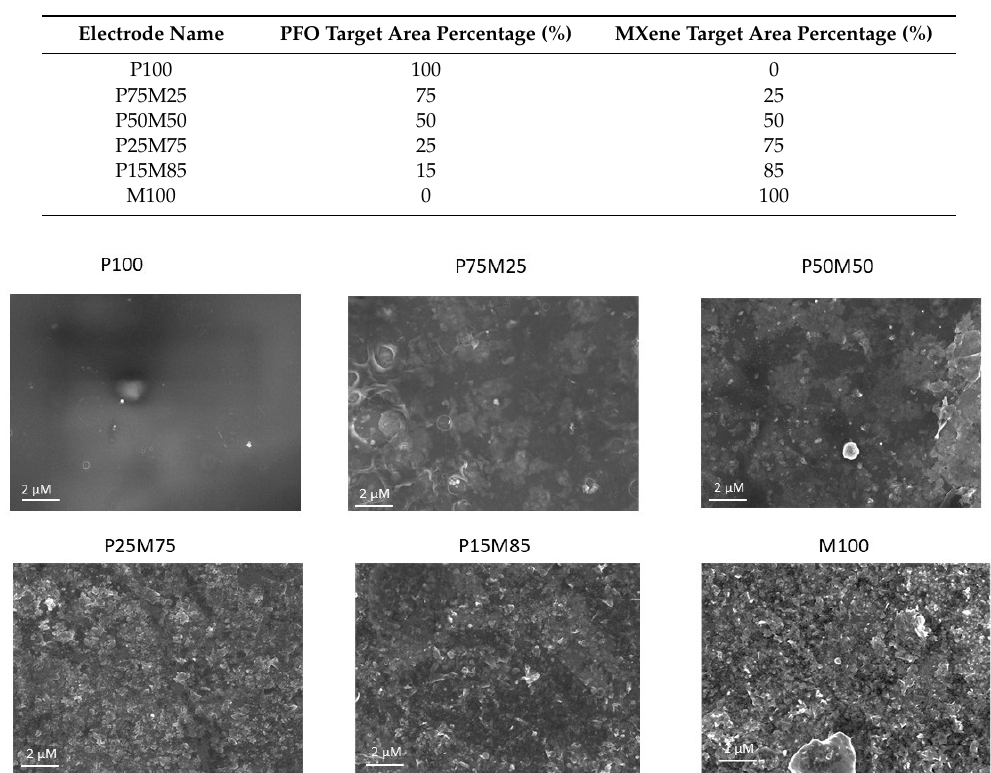
Table 1. List of electrode names tested where the percentages refer to the area of the target in resonant infrared matrix-assisted pulsed laser evaporation (RIR-MAPLE), as well as naming convention. PFO: polyfluorene.